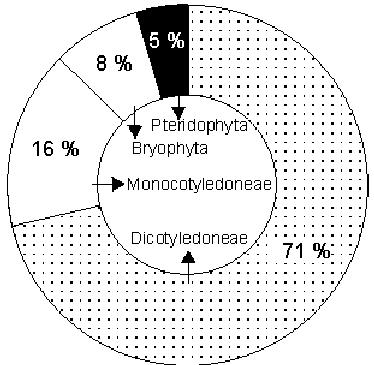
Fig. 2. Plant divisions reflected as a percentage of the total number of plant